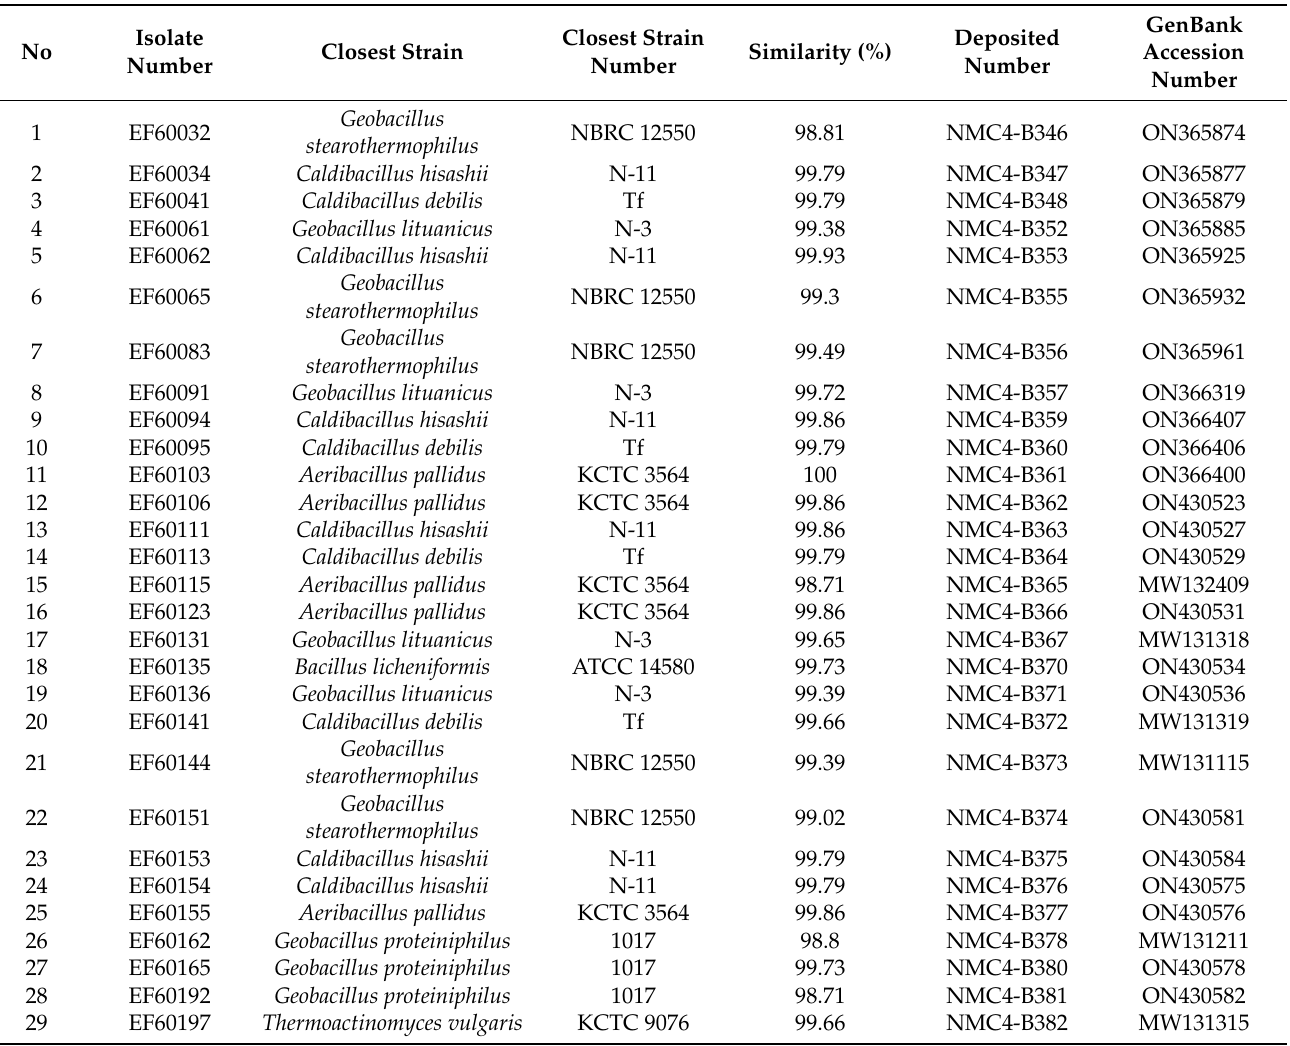
Table 4. Taxonomic identification of the isolates based on 16S rRNA gene